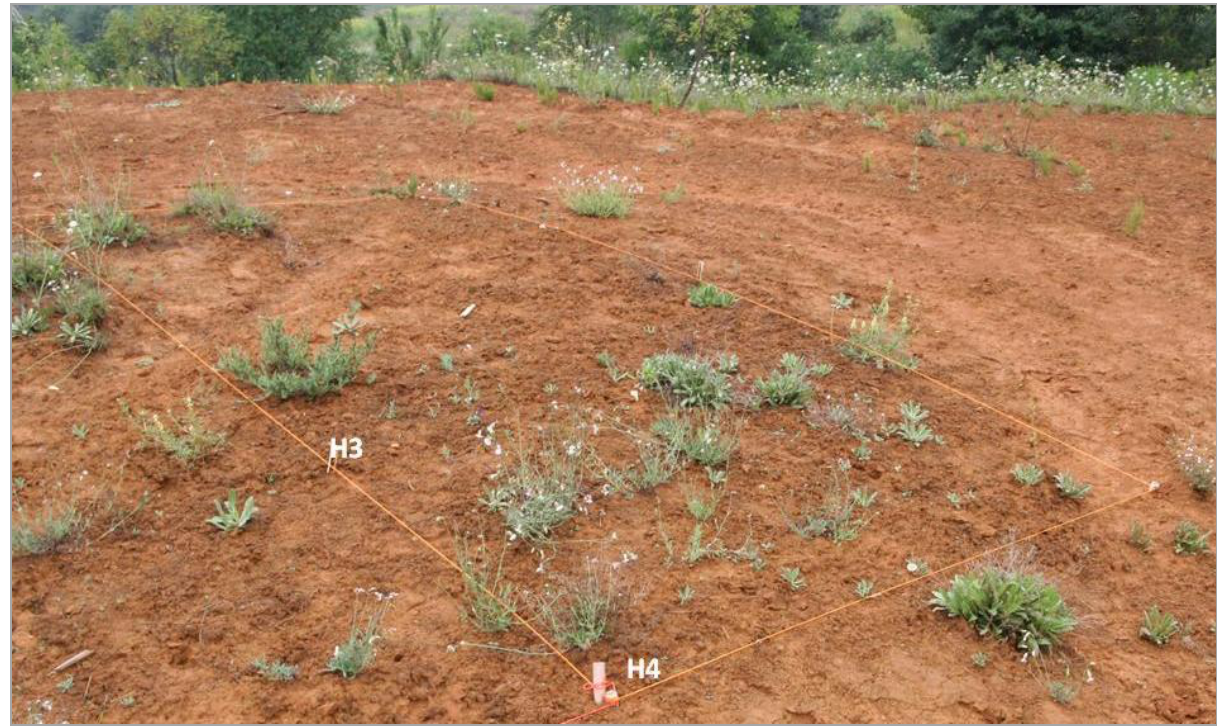
Fig. 9. Comparison of hay strewn and mulched plots in 2009 and 2014 ( A. Rostański )